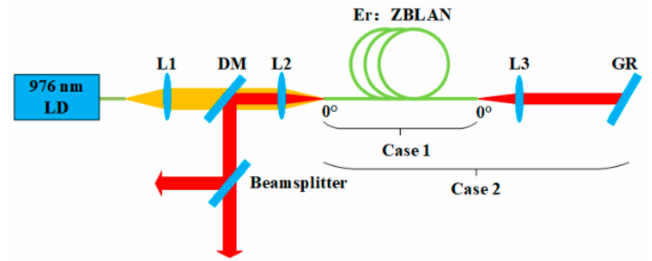
Figure 1. Experimental setup of the laser